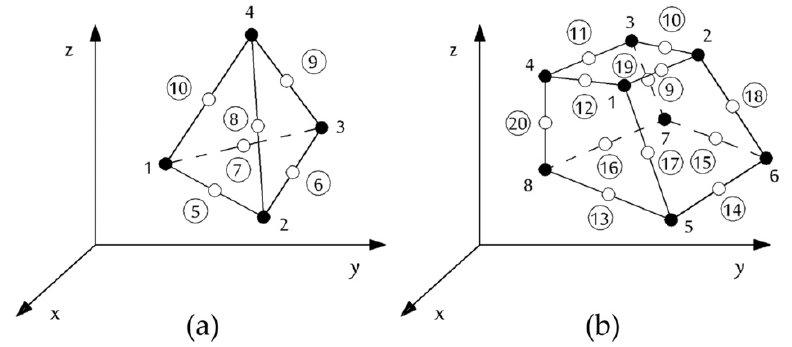
Figure 14. The geometry of the 3D solid elements [26,46]: ( a ) tetrahedral elements with 4 to 10 nodes; ( b ) brick elements with 6 to 15 nodes.